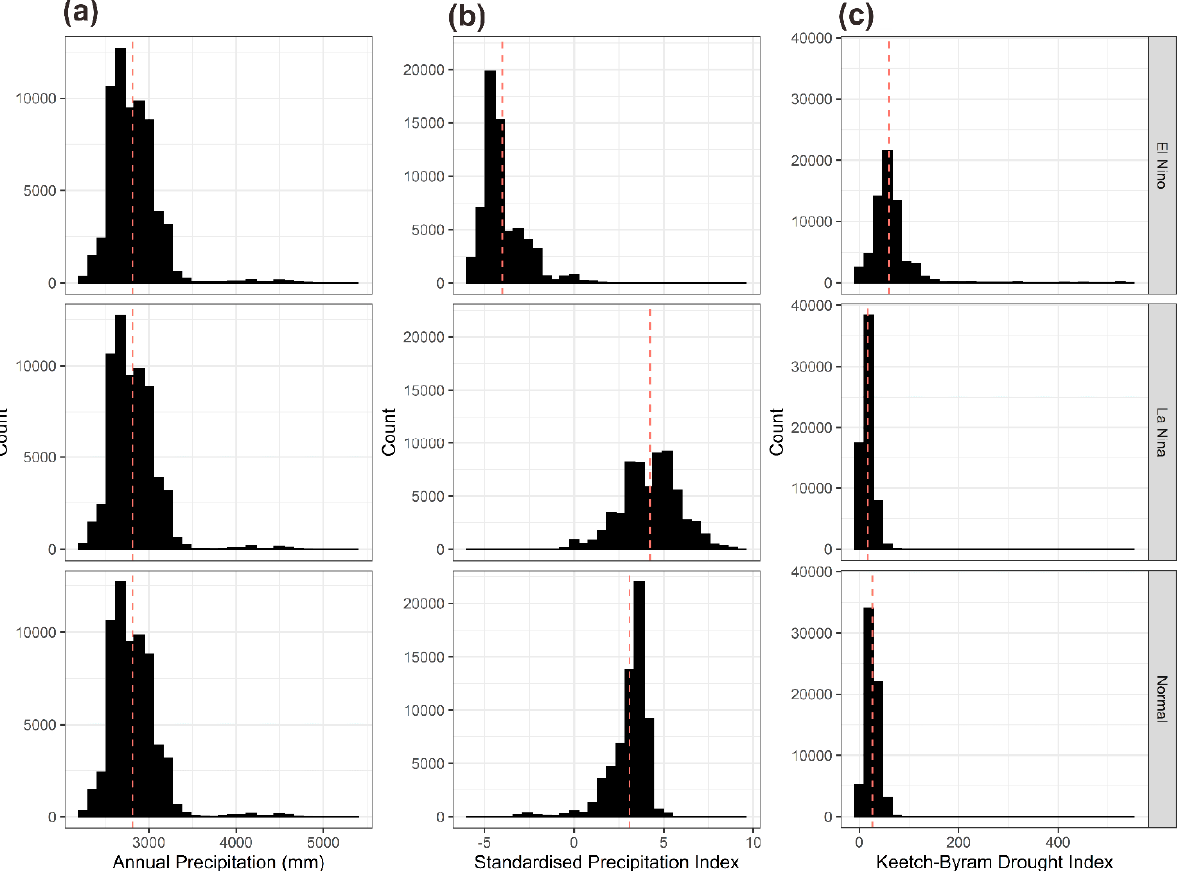
Figure 3. Annual precipitation ( a ); Standardized Precipitation Index ( b ); and Keetch-Byram Drought Index ( c ) under various ENSO phases. The red dashed line depicts the average value from the data for each ENSO phase.